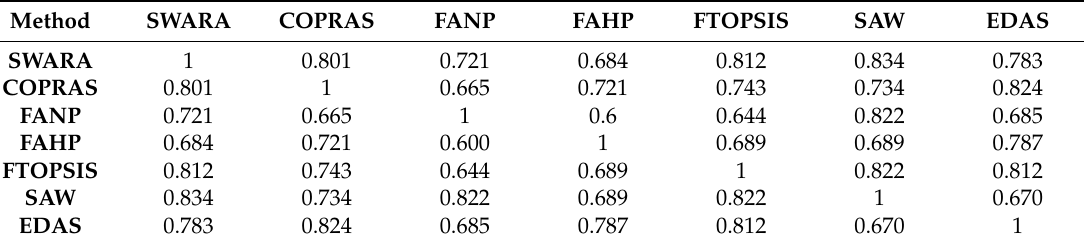
Table 8. Kendall’s coefficient results.